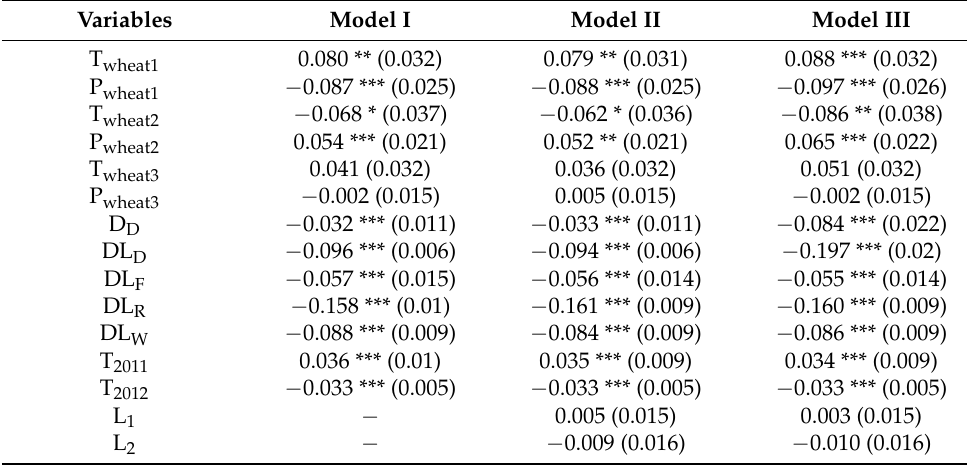
Table 6. The estimated results of influencing factors of winter wheat